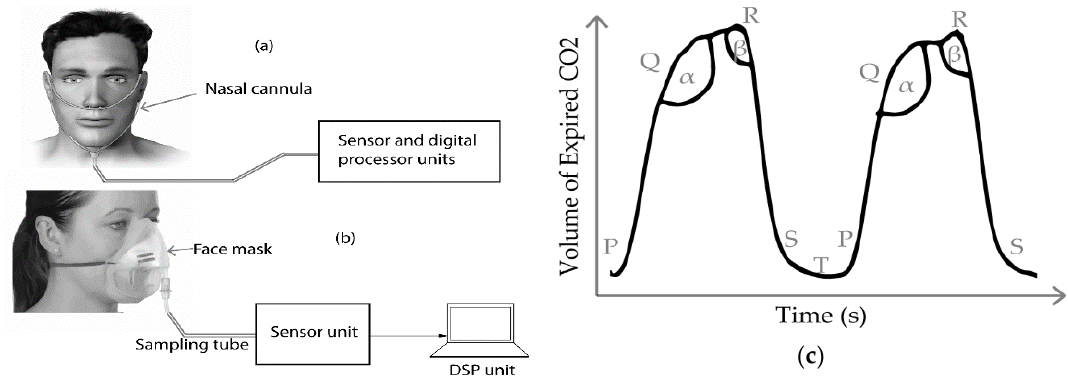
Figure 3. CO 2 measurement techniques: ( a ) sidestream; ( b ) mainstream; ( c ) description of a capnogram [47].